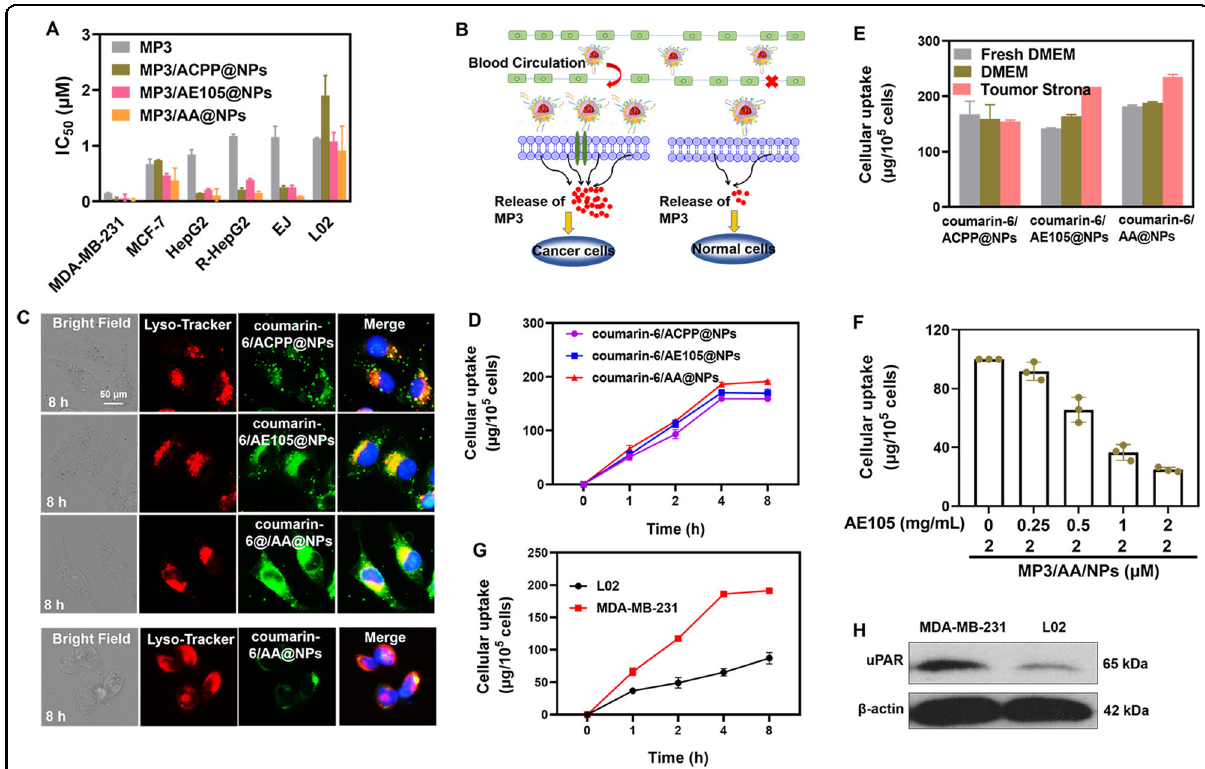
Fig. 3 In vitro anticancer activity and cellular uptake of nanoparticles. A Antiproliferation activity of MP3, MP3/ACPP@NPs, MP3/AE105@NPs and MP3/AA@NPs against various cells. B The schematic of selective cellular uptake of MP3/AA@NPs. C Live imaging of coumarin-6/ACPP@NPs, coumarin-6/AE105@NPs, coumarin-6/AA@NPs in MDA-MB-231 cells and L02 cells. Quantitative analysis of coumarin-6/ACPP@NPs, coumarin-6/ AE105@NPs, coumarin-6/AA@NPs ( D ) in MDA-MB-231 cells ( E ) in fresh DMEM, DMEM, and the tumor storma. F The uptake attenuation effect of AE105 on MP3/AA@NPs in MDA-MB-231 cells. G The accumulation of coumarin-6/AA@NPs in MDA-MB-231 and L02 cells. H The uPAR protein expressed in the MDA-MB-231 cells and L02 cells, as determined by western